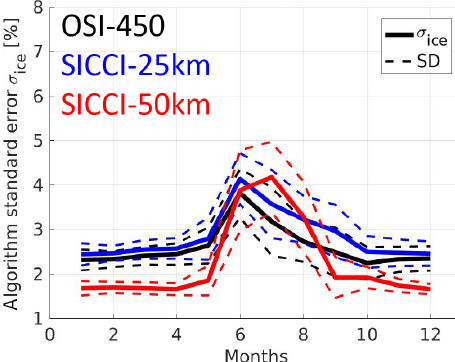
Figure 1. Seasonal cycle of the multi-annual (2002–2011) aver- age sea-ice concentration algorithm standard error for the Arctic for grid cells with more than 90% sea-ice concentration for OSI- 450, SICCI-25km, and SICCI-50km products. Shown are the mean (solid line) and its standard deviation (dashed line denoted